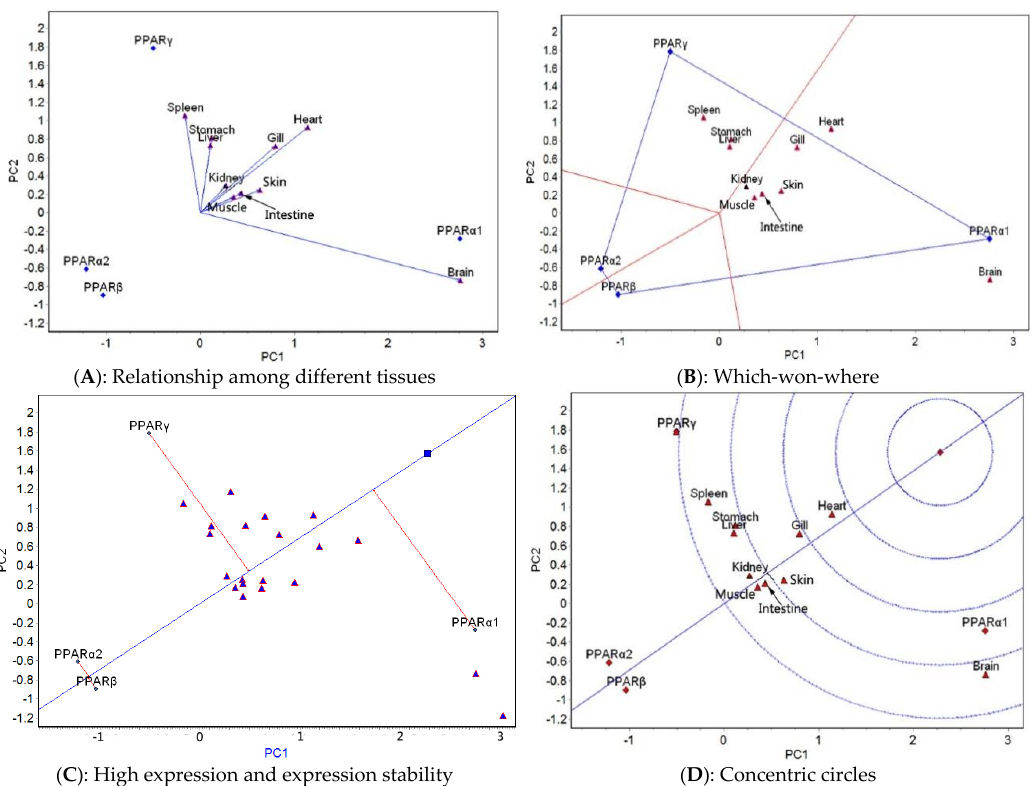
Figure 7. GGE biplots of PPAR genes in different tissues at 28 °C. The results of the GGE biplot analysis of the relationship among different tissues (panel A, Figures 3–7) mainly reveal the similarity of gene expression among tissues. The included angle of the two line segments indicates the correlation of the gene expression ranking in the tissue represented by the two line segments. When the included angle of the two segments is acute, the gene expression ranking in the two tissues is positively correlated: the smaller the angle, the higher the correlation and the closer the gene expression ranking. When the angle between the two segments is obtuse, the gene expression ranking is negatively correlated in the two tissues, and when the angle between the two segments is a right angle, the gene expression ranking in the two tissues is not related. The length of the line segment indicates the ability of the tissue to distinguish gene expression, with a longer line segment indicating stronger ability to distinguish gene expression. The which-won-where view of the GGE biplot (panel B, Figures 3–7) divides the experimental regions according to genotype × tissue interaction and identifies genes with the highest expression level in each region. The gene located at the top corner of the polygon in each region is the gene with the highest expression in this region. The high expression and expression stability biplot (panel C, Figures 3–7) shows the genes with high and stable expression. The direction of the transverse oblique line to the ideal value is the approximate average expression of the gene in all tissues: the closer to the ideal value, the higher the average gene expression. The straight line perpendicular